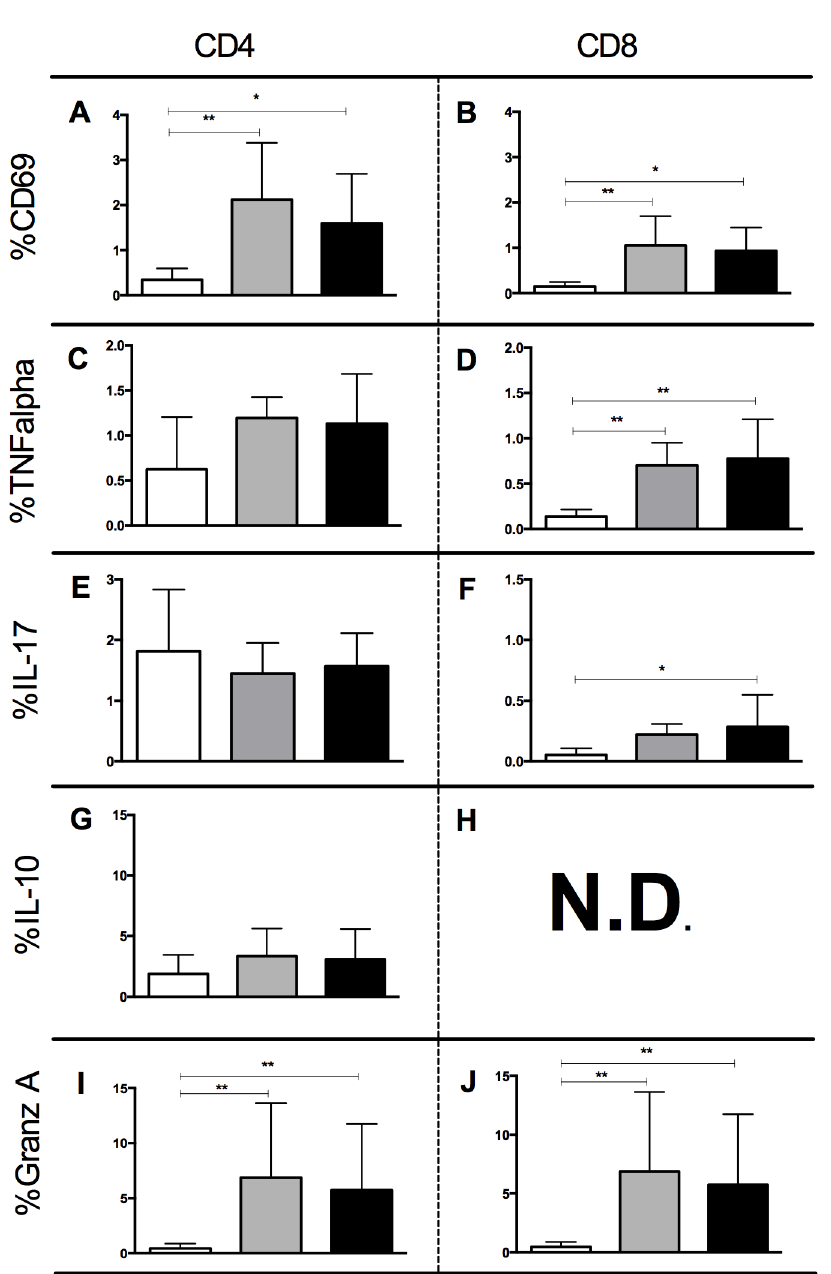
Fig 4. Determination of the percentage of expression of CD69, TNF-alpha, IL-17, IL-10, TNF-alpha and Granzyme A in CD4 and CD8 lymphocytes after exposure to monocytes infected with Y strain and Col cl1.7. Results are expressed as average ± standard deviation. The symbol * indicates p < 0.05 between groups. Determination of percentage of (A) CD69+ CD4+ after 72 hours of culture; (B) CD69+CD8+ after 72 hours of culture; (C) TNF-alpha+CD4+ after 72 hours of culture; (D) TNF-alpha+CD8+ after 72 hours of culture; (E) IL-17+CD4+ after 15 hours of culture; (F) IL-17+CD8+ after 15 hours of culture; (G) IL-10+ CD4 + after 72 hours of culture; (H) ND; (I) Granzyme A+CD4+ after 72 hours of culture (J) Granzyme A+CD8 + after 72 hours of